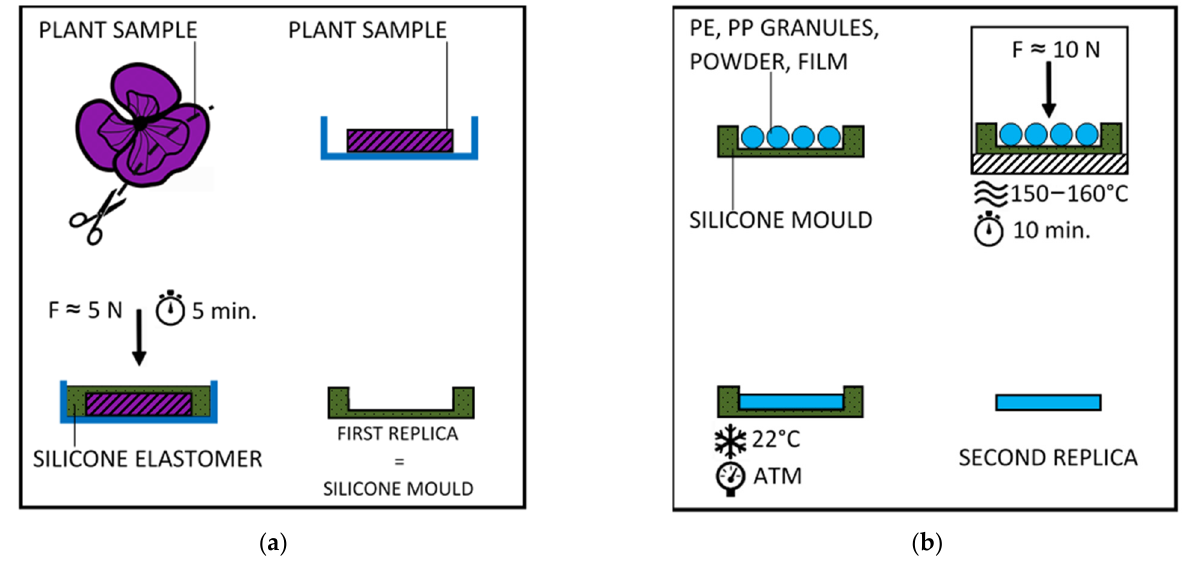
Figure 3. Replication process. ( a ) The method of forming the first (negative) elastomeric replica. ( b ) The method of forming the second (positive) polymer replica.